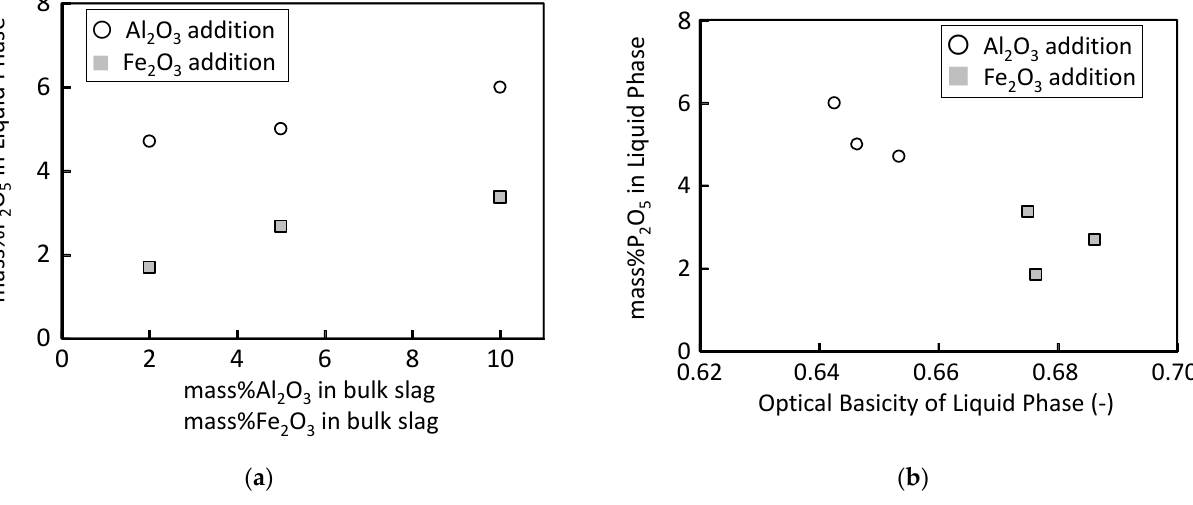
Figure 15. ( a ) Change in P 2 O 5 content in the liquid phase with Al 2 O 3 /Fe 2 O 3 content in the bulk slag; ( b ) change in P 2 O 5 content in the liquid phase with an optical basicity of the liquid phase.